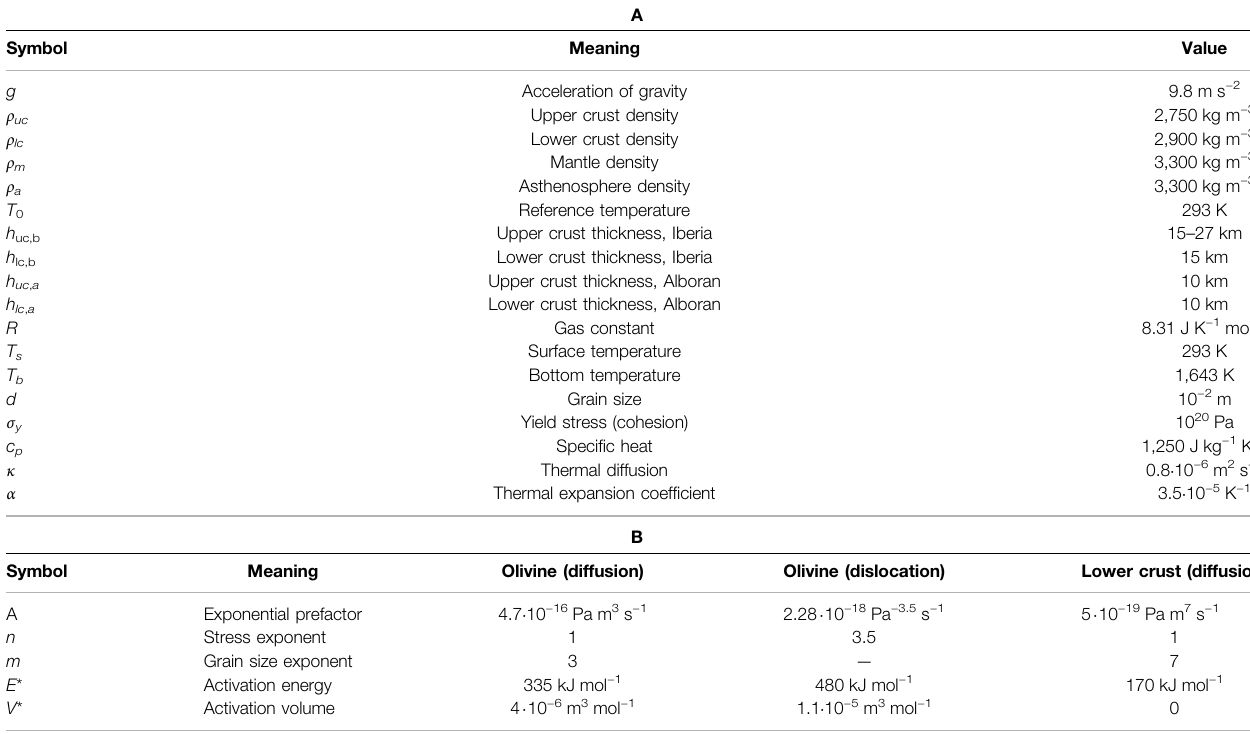
TABLE 1 | (A) . (B) Parameters considered for a wet-olivine rheology (Hirth and Koldstedt 2003) and feldspar (Bürgmann and Dresen, 2008).